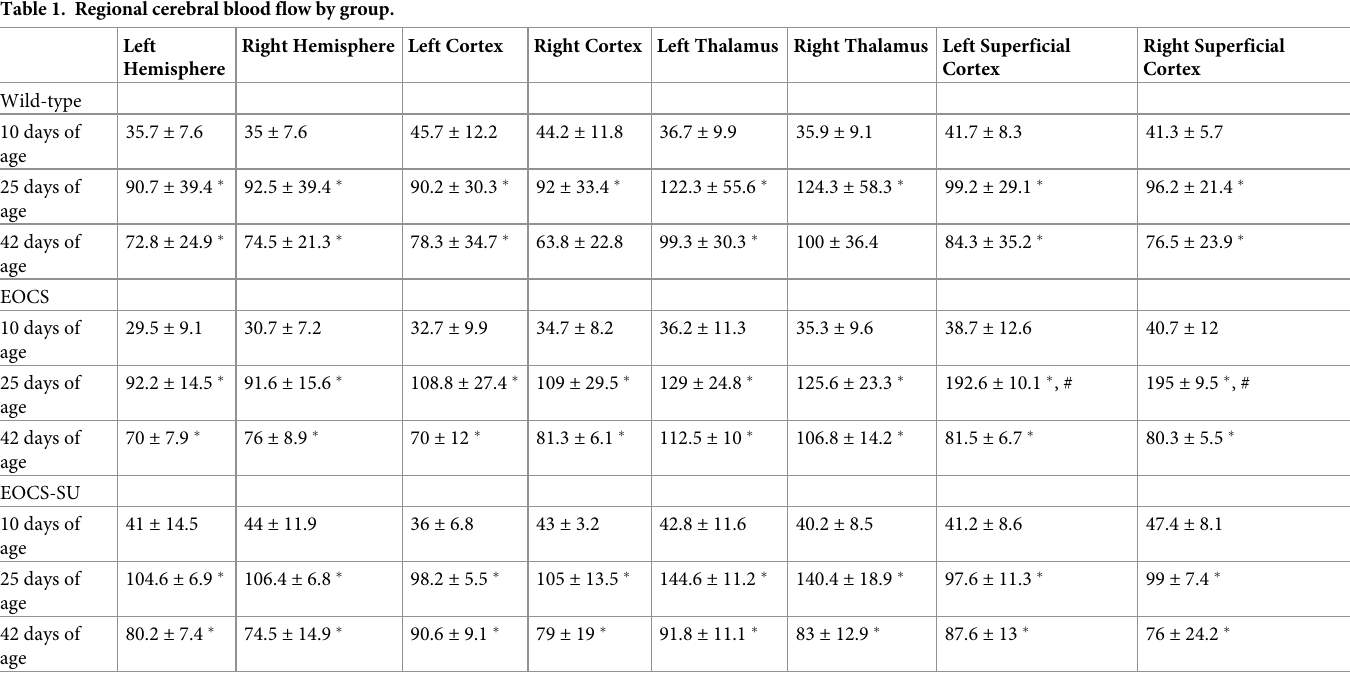
Right Superficial Cortex